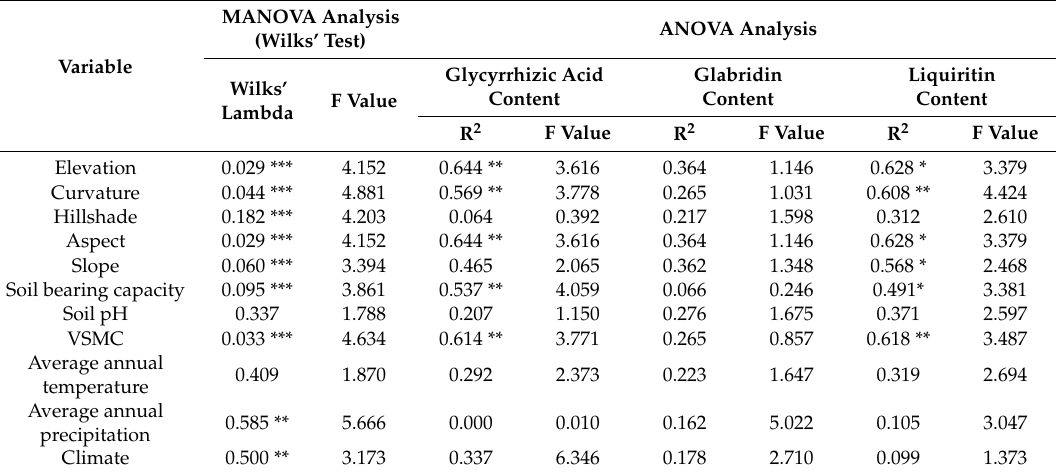
Table 2. Statistical e ff ects of tested variables on the bioactive contents of G. glabra